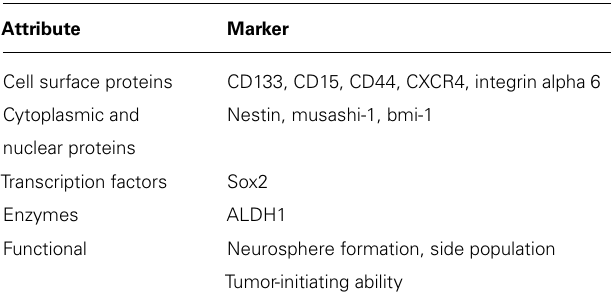
Table 1 | Markers used to identify glioma stem